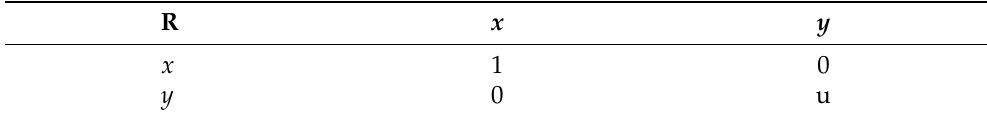
Table 1. The L -valued relation E in Example